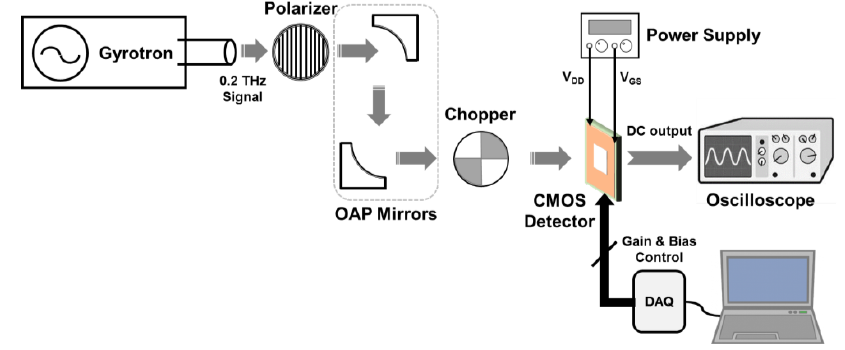
Figure 7. Measurement setup for calculating the voltage responsivity of the proposed detector.